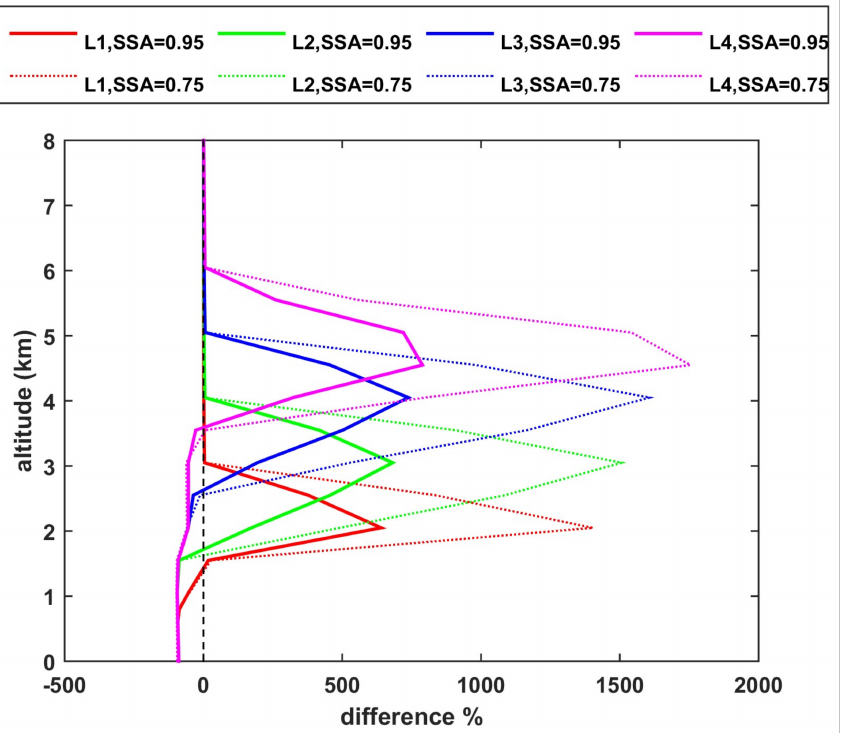
Figure 5. Change (in %) in the profiles of HR for SW radiation. The presented results are for AOD = 1, SZA = 60 ◦ , surface albedo = 0.1, water vapor = 1 g/cm 2 , and two values of the SSA: 0.75 (dotted lines) and 0.95 (solid